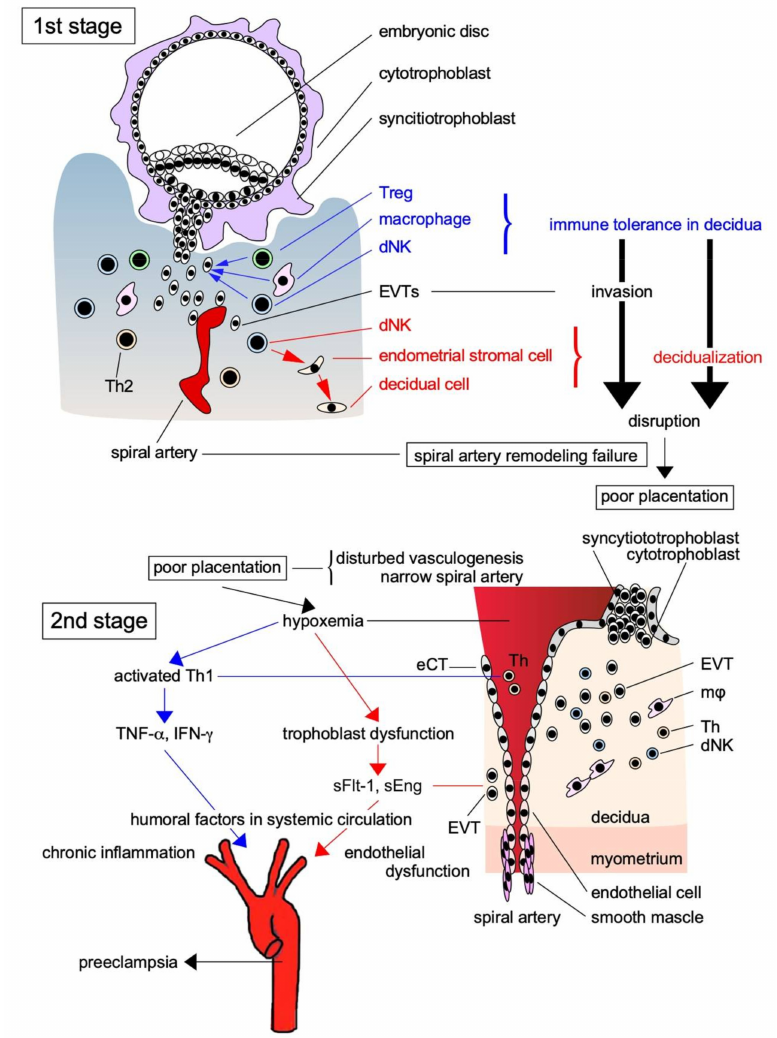
Figure 1. Two-stage theory of the pathogenesis of PE. The pathogenesis of PE is explained by the two-stage theory: in the first stage, EVTs as the paternally antigenic fetal components infiltrate toward the spiral artery without being eliminated by the maternal immune system due to immune tolerance by Treg and other immune cells, and supply a large amount of maternally derived blood to the placenta resulted in the successful placentation. However, when placentation is impaired by the breakdown of immune tolerance, anti-angiogenic factors and proinflammatory factors produced by placental ischemia in the second stage are released into the systemic circulation, causing multiple organ failure due to the vascular injury. Treg: regulatory T cell; dNK: decidual natural killer cell; Th: helper T cell; sFlt-1: soluble fms-like tyrosine kinase-1; sEng: soluble endoglin; TNF- α : tumor necrosis factor- α ; INF- γ : interferon- γ ; eCT: endovascular